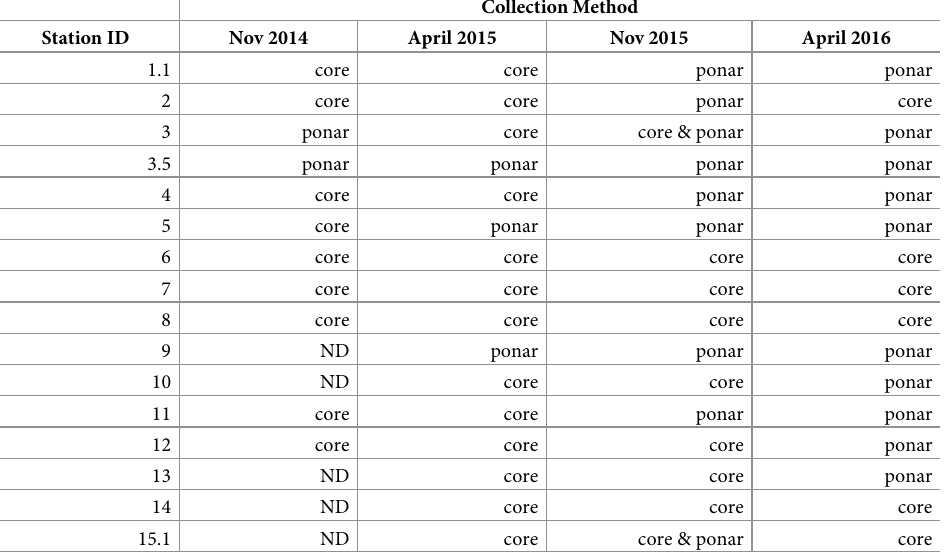
Table 1. Samples were collected at each station using either a corer or ponar. While core samples were preferable, technical difficulties or sediment composition called for the use of a ponar at several sites. Samples that were not col- lected are indicated by “ND” (No